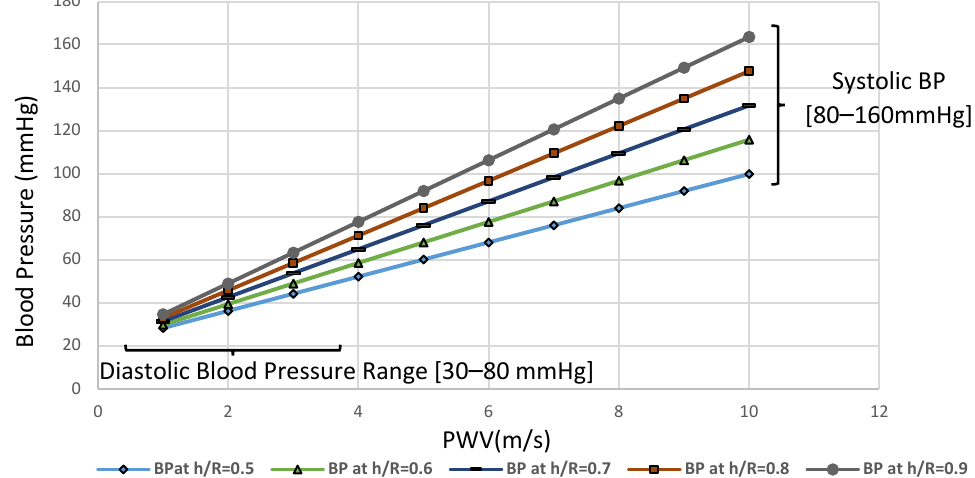
Figure 19. Blood pressure P versus normalized PWV for human brachial artery. The absolute risk of arterial blood pressure increased in relation to artery PWV.